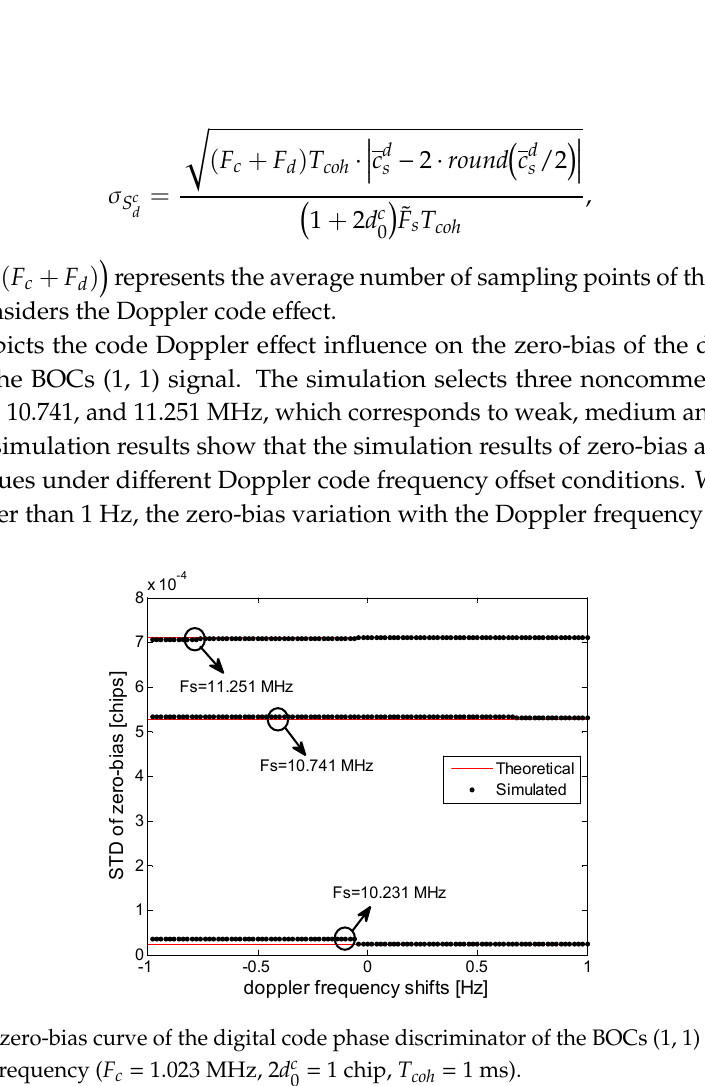
= 1 chip, T = 1 F = 1.023 MHz, T = 1 ms). 2 c d = 1 chip, coh 0 c coh 0